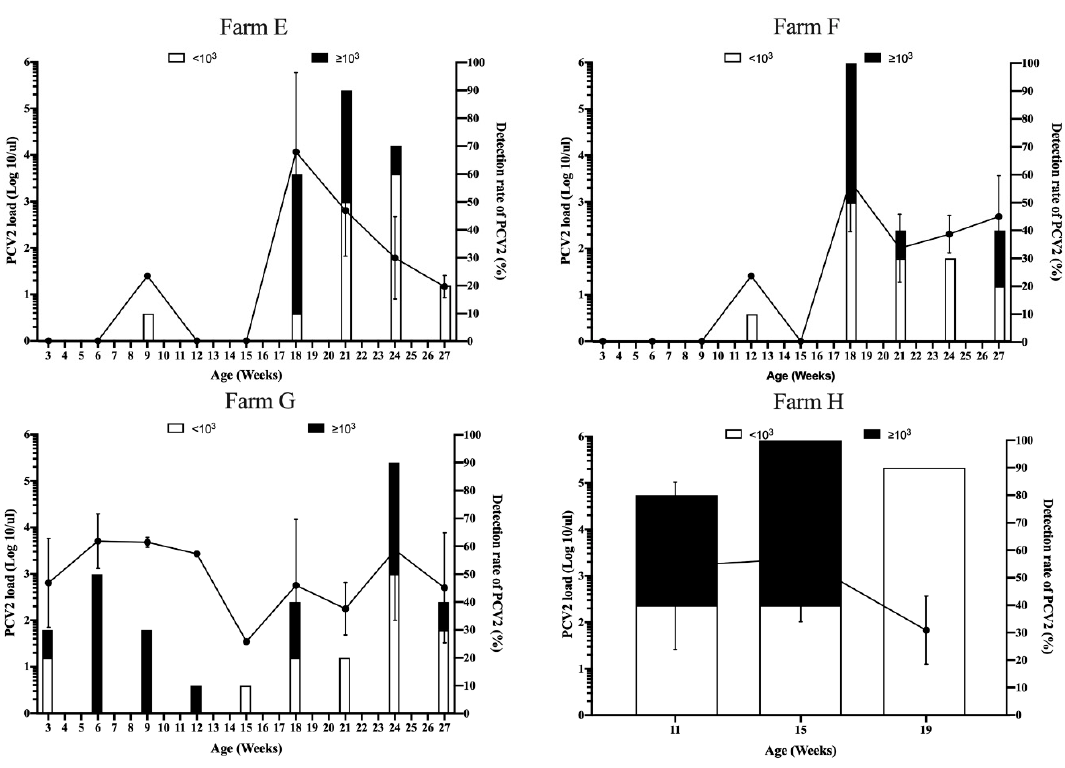
Figure 4. Viremia loads (line graph, left Y axis) and detection rate (bar chart, right Y axis) of porcine circovirus type 2 (PCV2) in pigs born from the sow mass PCV2 vaccination group, Farms E, F, G, and H. The error bars show the standard deviation (SD) of positive samples.